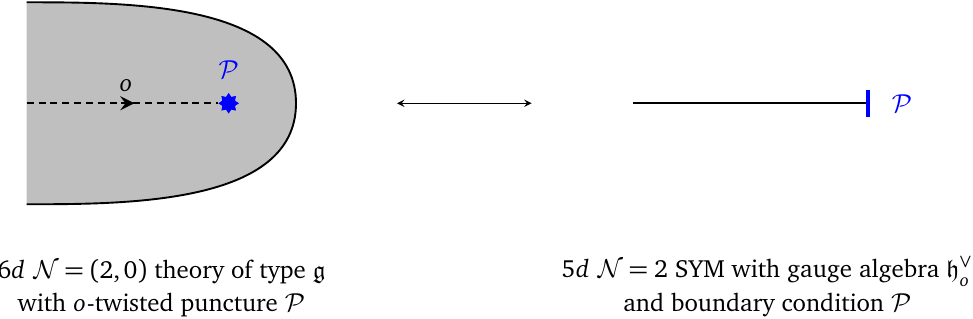
Figure 4: Compactifying 6 d N = ( 2,0 ) theory of type g on a cigar-like non-compact surface with an o -twisted puncture P placed at the tip of the cigar is equivalent to 5 d N = 2 SYM theory on a half-line with gauge algebra h ∨ associated to P (which, by an abuse of notation, we label by P in the figure) placed at the end of the